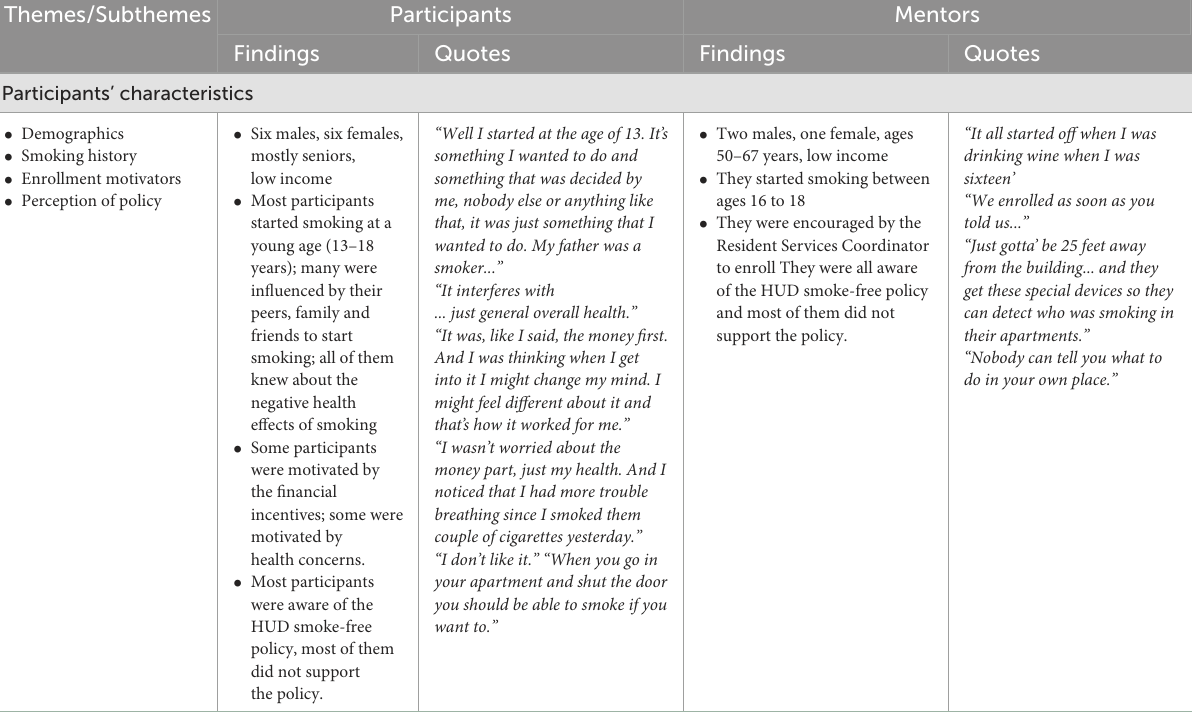
TABLE 6 Qualitative findings from public housing peer mentoring project.